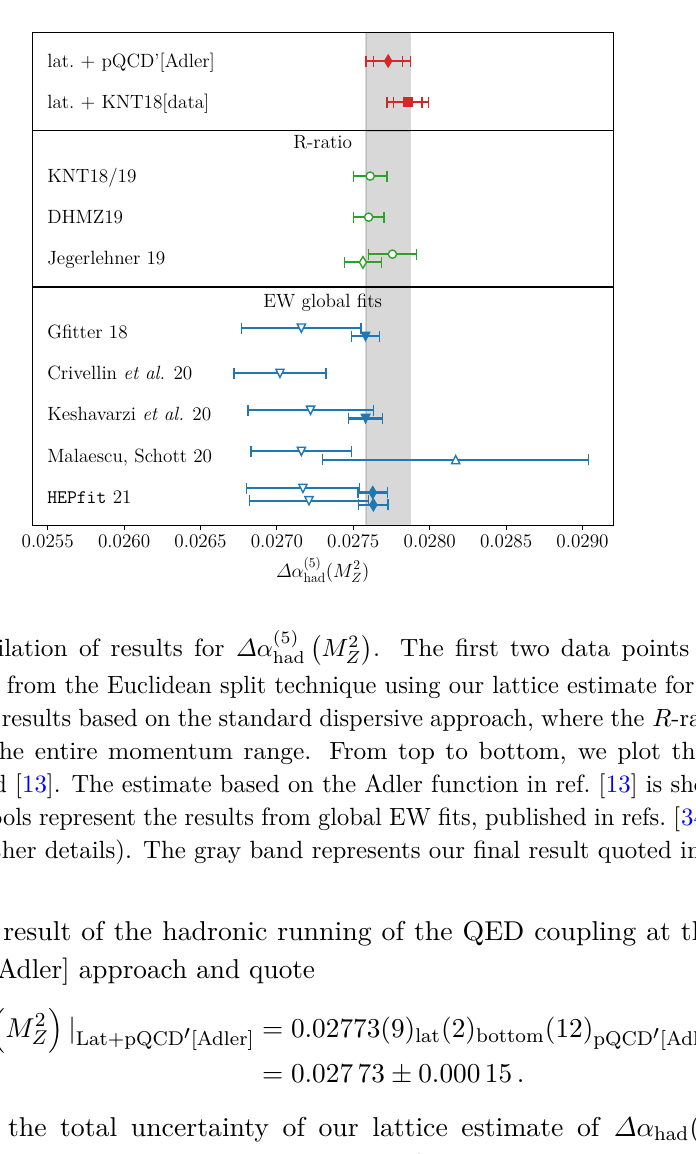
Figure 14 . Compilation of results for ∆α (5) represent the results from the Euclidean split technique using our lattice estimate for ∆α (5) Green circles denote results based on the standard dispersive approach, where the R -ratio integration is performed over the entire momentum range. From top to bottom, we plot the results from refs. [11, 12, 31], and [13]. The estimate based on the Adler function in ref. [13] is shown as a green diamond. Blue symbols represent the results from global EW fits, published in refs. [34–36, 142, 143] (see the text for further details). The gray band represents our final result quoted in eq.